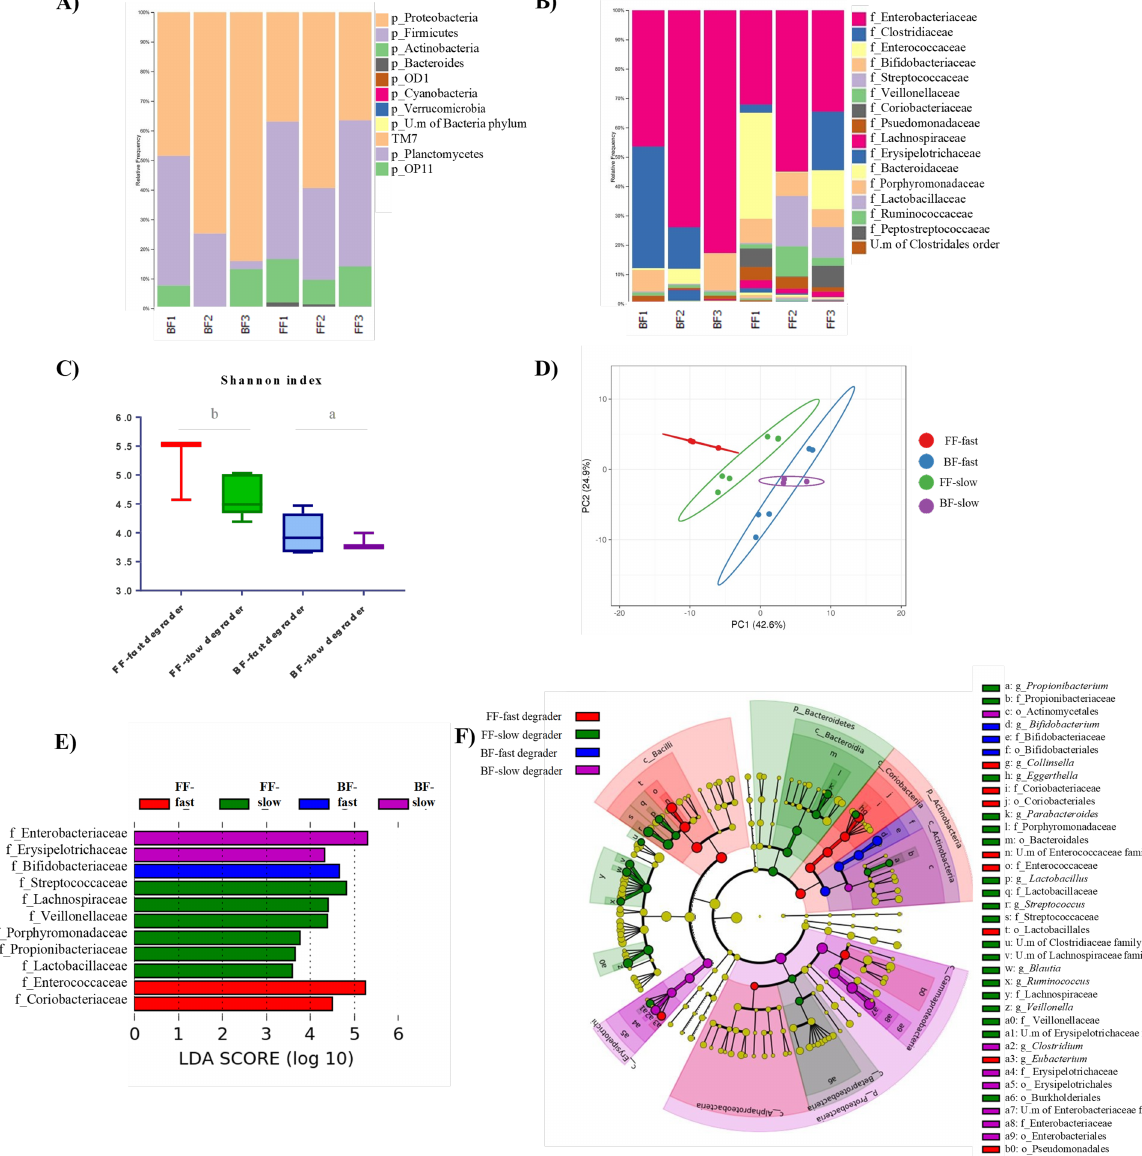
Figure 2. Characteristics of the microbiota from fecal inocula at baseline (T0). Relative abundance of bacteria at Phylum ( A ) and Family levels ( B ). Alpha diversity (Shannon index) of fecal inocula from the four groups generated according to feeding type and 2 (cid:48) FL degradation ability ( C ): letters indicate significant differences ( p < 0.05) between groups below lines. Principal Component Analysis of microbial compositional taxonomic data of inocula ( D ). Linear Discriminant Analysis (LDA) scores of microbial families significantly altered in the four inocula groups (combination of breastmilk (BF)/formula milk (FF) and Fast/Slow 2 (cid:48) FL degraders) ( E ). The most differentially abundant taxa in BF-fast degraders, BF-slow degrader, FF-fast degrader, and FF-slow degraders are represented as a cladogram generated from Logarithmic Linear Discriminant Analysis (LDA) Effect Size (LEfSe) analysis data where the color intensity of each dot is proportional to its effect size ( F